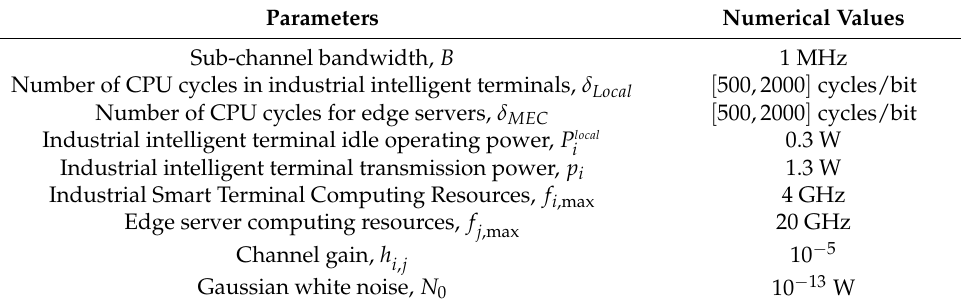
Table 1. Simulation